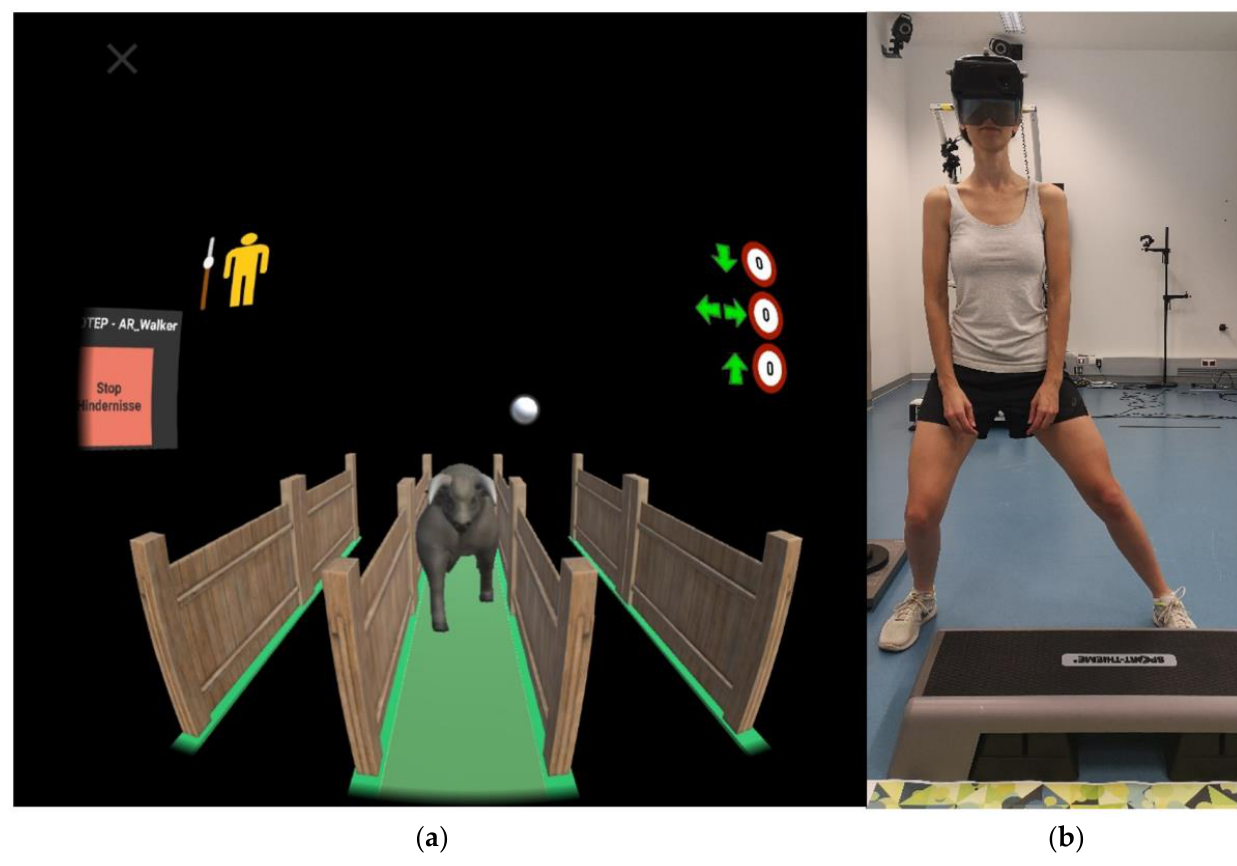
Figure 1. Performing the training game. ( a ) View of the user. The image shows the virtual objects which are placed in the user’s field of view. When using the training game, users see their surroundings instead of the black background. ( b ) The user, wearing the head mounted display, reacts to the obstacle (a bull) and performs a side-step.